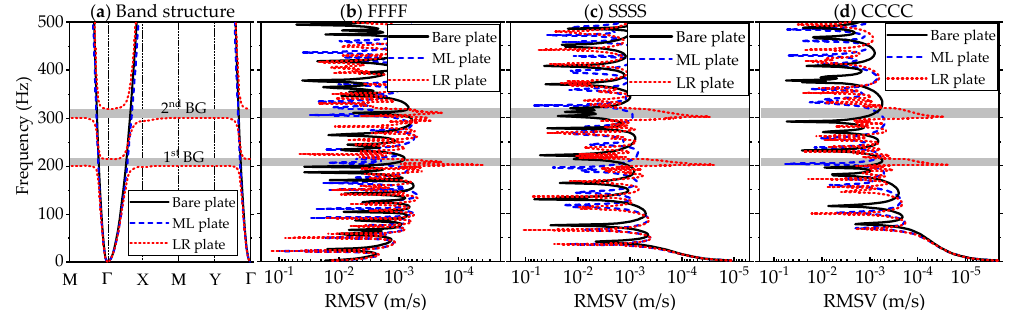
Figure 6. ( a ) Band structures of the infinite bare plate, mass-loaded (ML) plate, and locally resonant (LR) plate, and the root-mean-square velocities (RMSVs) averaged over the whole surface of their finite counterparts with ( b ) fully free (FFFF) boundary conditions, ( c ) fully simply supported boundary conditions (SSSS), and ( d ) fully clamped (CCCC) boundary conditions. (BG: band gap).